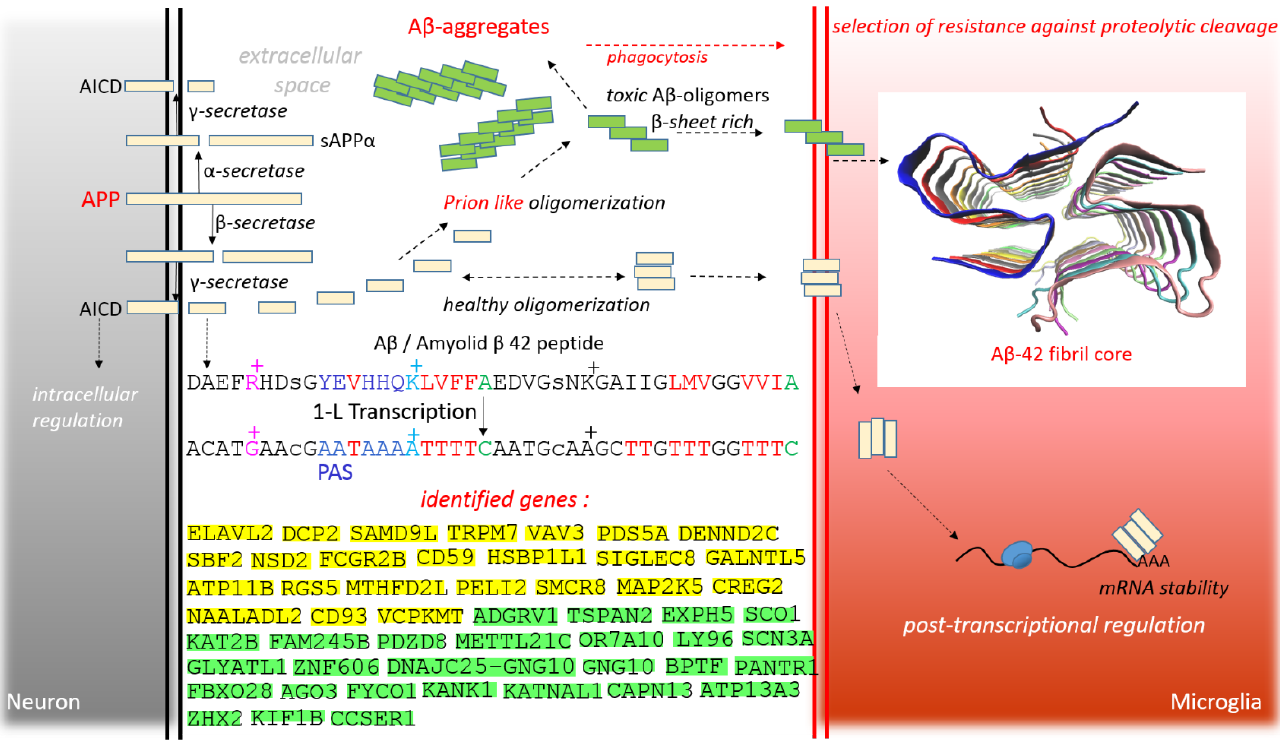
Figure 3. Two different pathways of APP processing in PM, and healthy oligomerization of Aβ peptide to elicit immune responses versus toxic prion oligomerization. The 1- L transcription of the Aβ peptide identifies the PAS sequence and the TTTC sequence (U-rich ARE class III). Genes identified by 1-L transcription, green highlights show alignments with complement sequence (post-transcriptionally repressed), yellow highlights show alignments with reverse complement sequence (post-transcriptionally promoted).